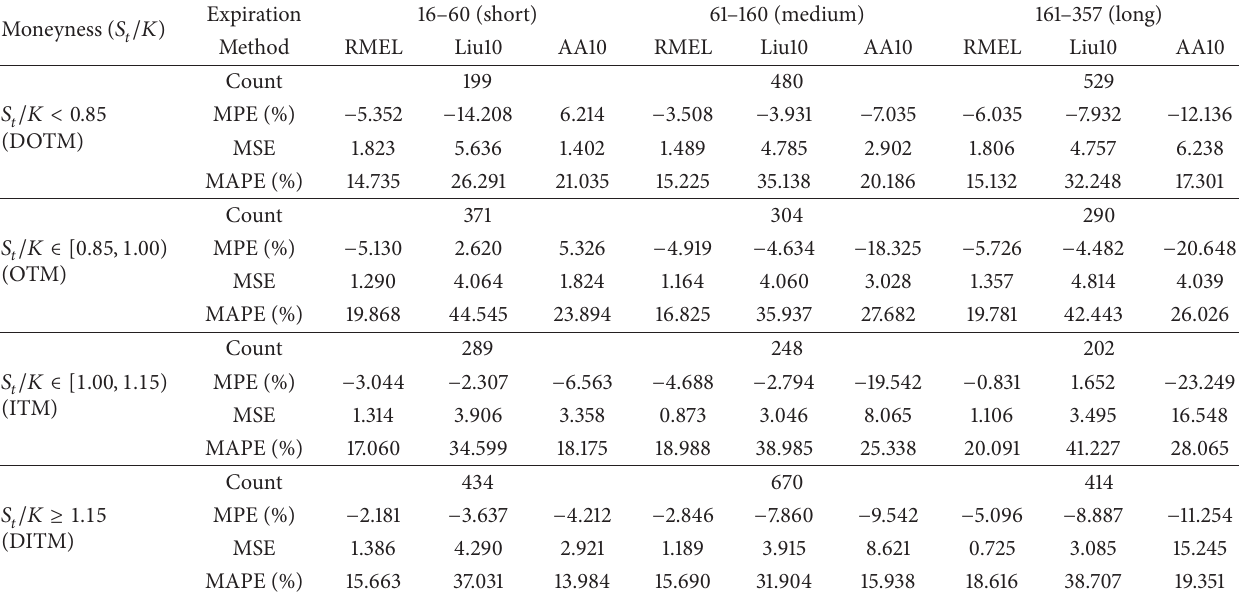
Table 5: MPE, MSE, and MAPE of IBM call price estimates compared to IBM market prices for a range of moneyness and time to expiration. Moneyness (𝑆 𝑡 /𝐾)